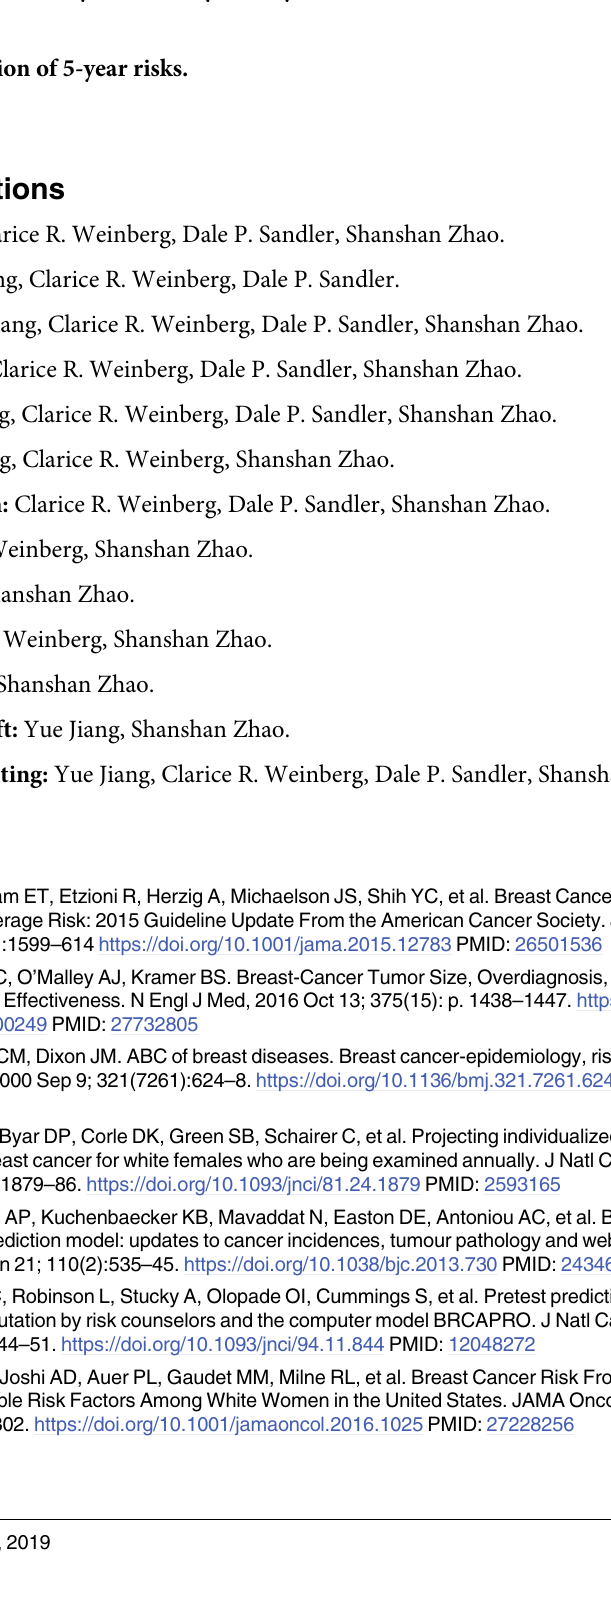
S1 Fig. Illustrative Lexis